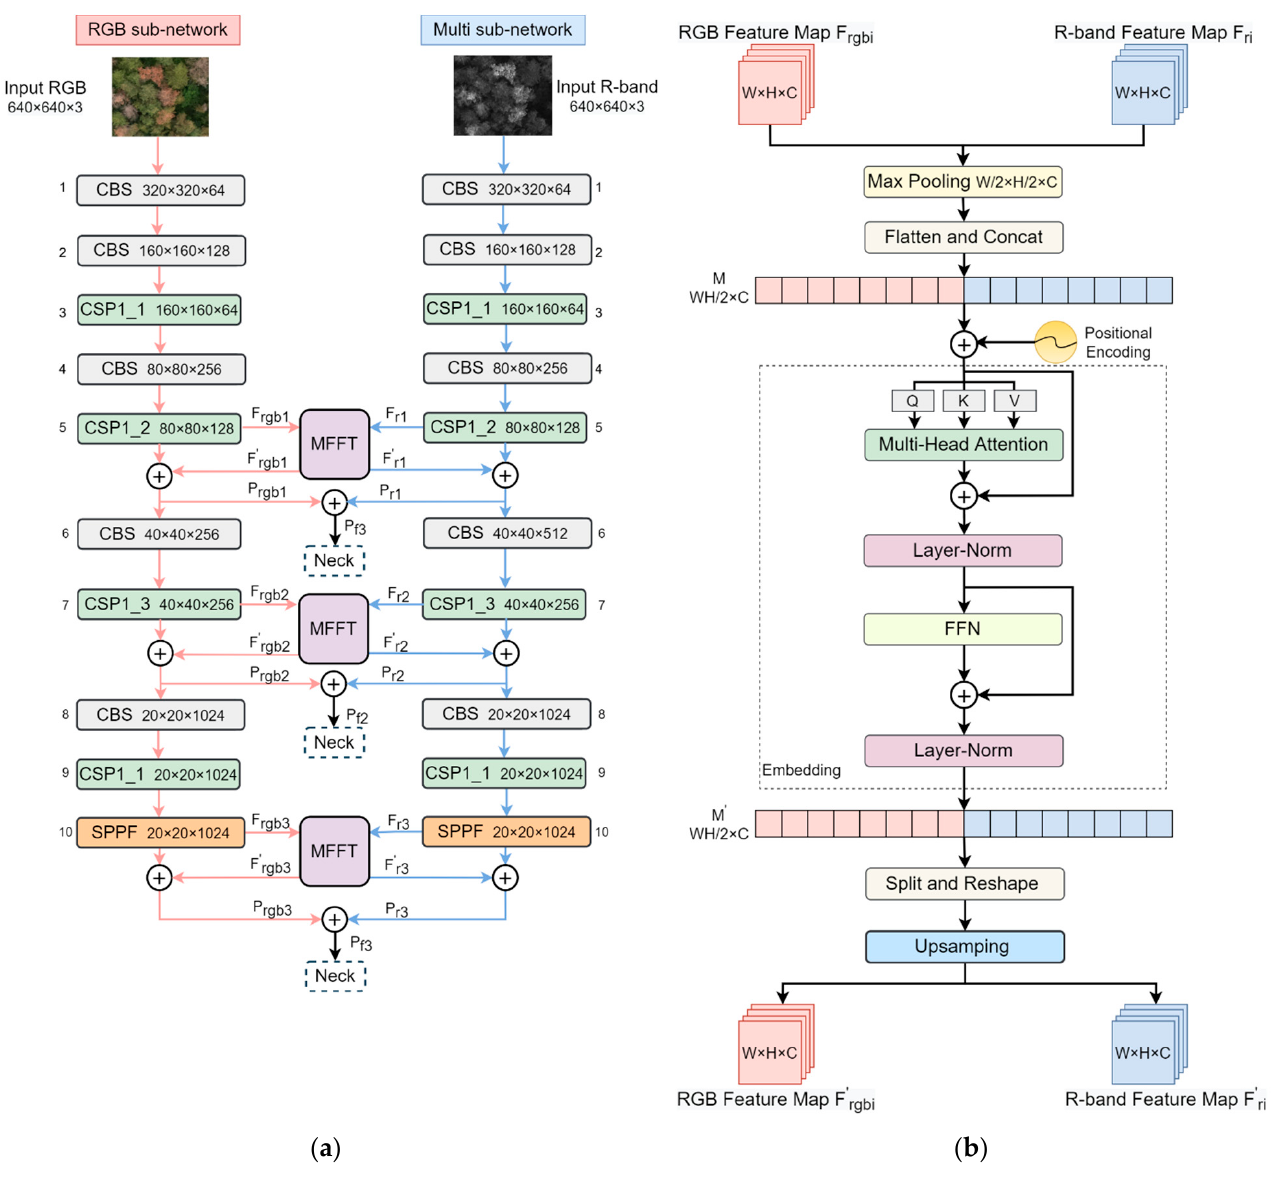
Figure 9. Structure of proposed MFTD: ( a ) Backbone of MFTD, ( b ) structure of MFFT module.